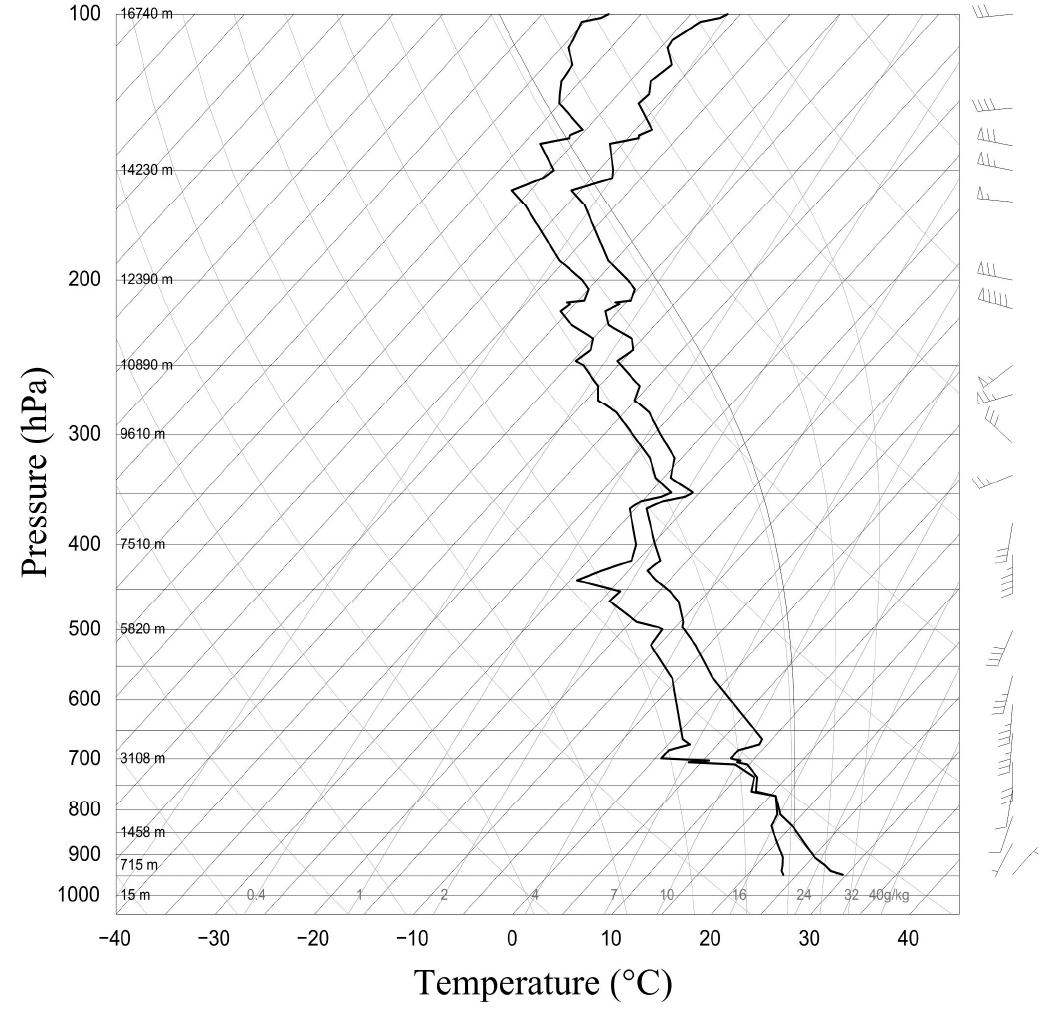
Figure 1. Initial sounding of temperature ( solid line ) and dew-point ( dashed line ) plotted on skew T/log P diagram for Bismarck, North Dakota, USA, valid on 21 July 2014 at 21 h. Coordinate lines denote pressure (hPa) and temperature (°C). The height values and the wind barbs are shown on the right-hand side of the figure.